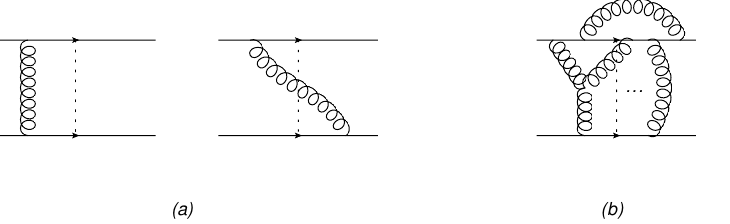
Figure 8: Example virtual gluon radiation at (a) 1-loop order; (b) arbitrary loop